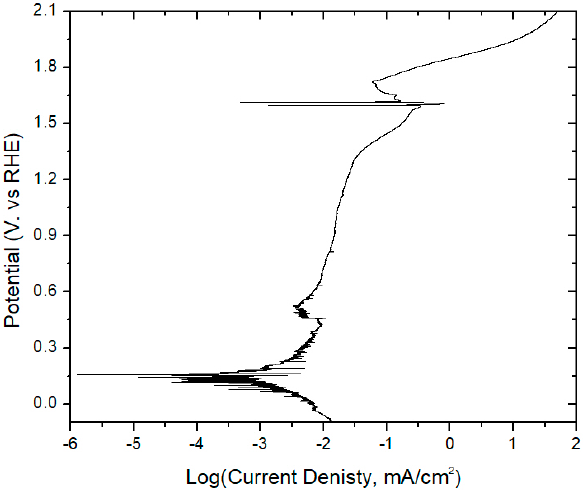
Figure 2. Example potentiodynamic polarization curve (scan rate: 50 μ V·s − 1 ) of a PbAg anode in 1.6 M H 2 SO 4 with open circuit features indicative of electrode surface polarization states, with the open circuit E corr at the most negative Log (Current Density) being variable based on the catalyst present in solution (Mn 2+ /Co 2+ ). The above data were gathered immediately after 30 min of electrolysis at 2.06 V vs. RHE.